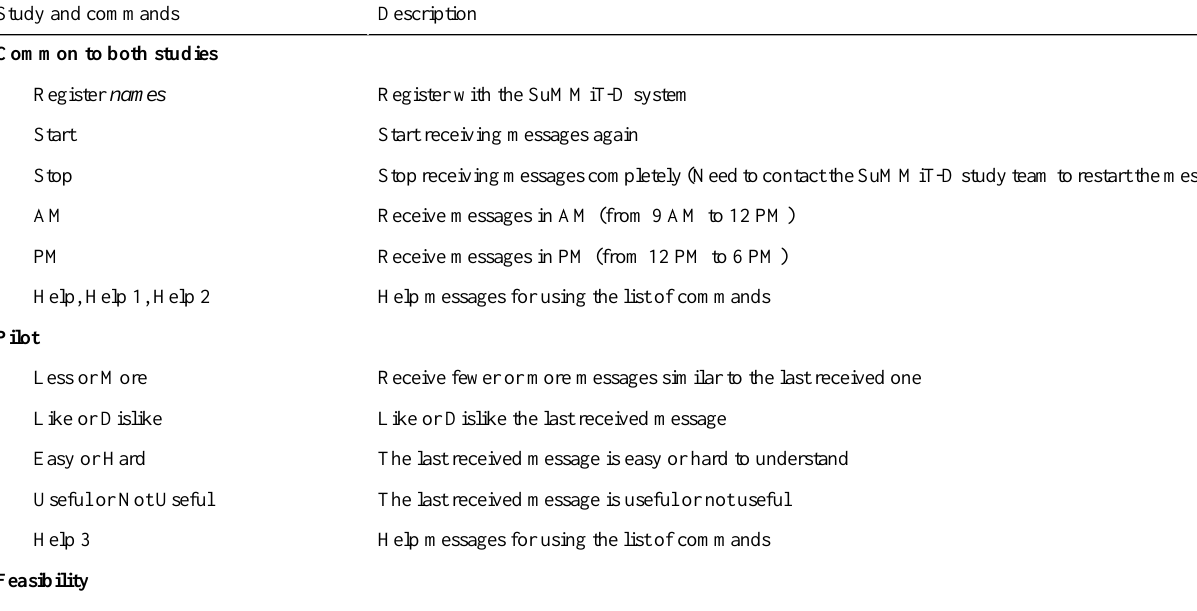
Table 1. List of commands available in the Support through Mobile Messaging and Digital Health Technology for Diabetes system and the corresponding